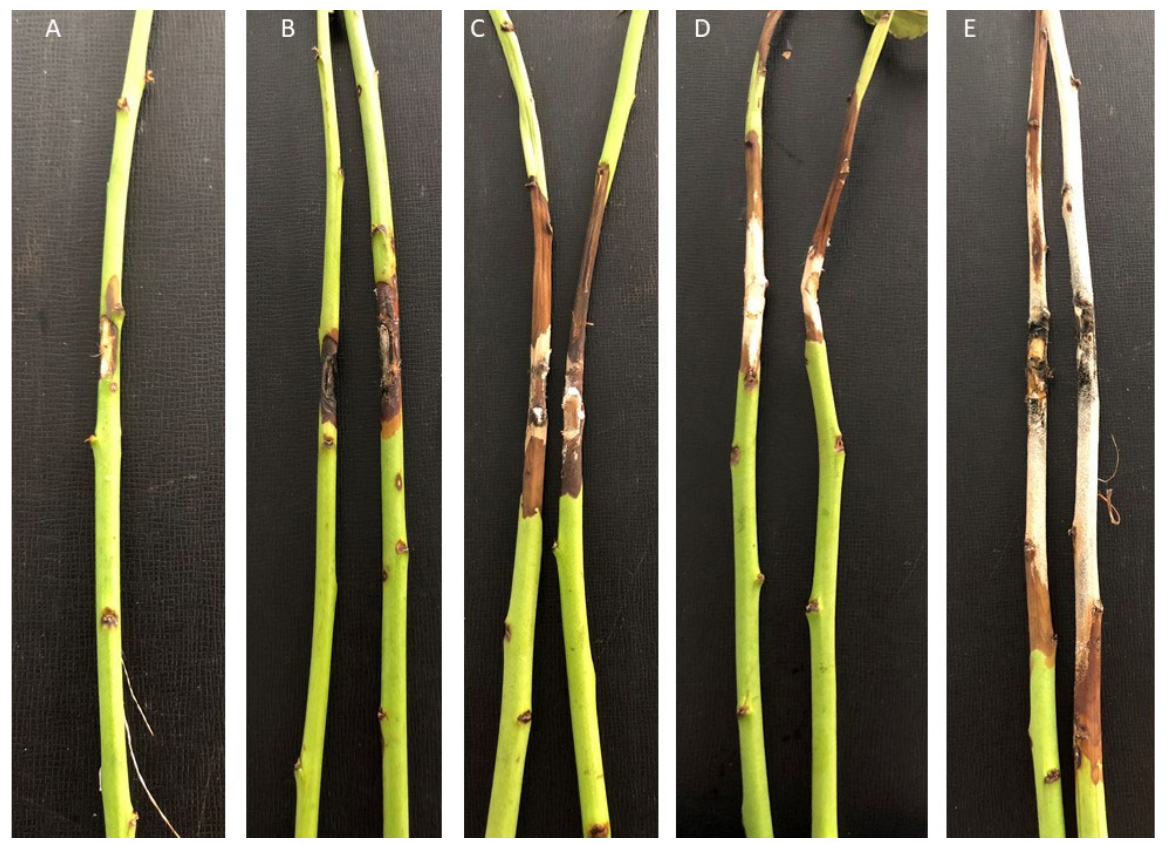
Figure 8. Results of pathogenicity test after two weeks. ( A ) Control. ( B ) Curvularia hawaiiensis . ( C ) Fusarium ambrosium . ( D ) Chondrostereum purpureum and ( E ) Lasiodiplodia theobromae .